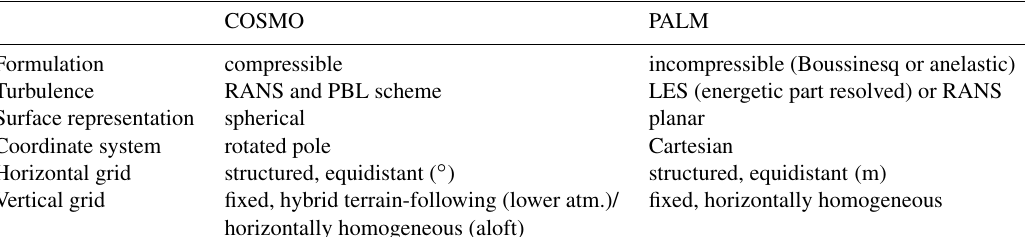
Table 2. Model differences between COSMO and PALM. PBL is the planetary boundary layer. RANS stands for Reynolds-averaged Navier– Stokes equations.